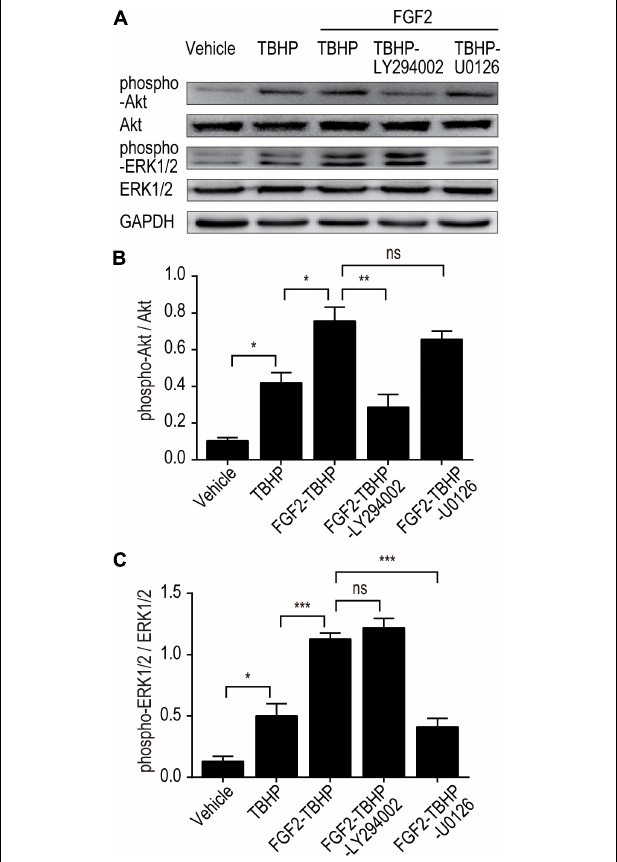
FIGURE 7 | LY294002 and U0126 abolish the effect of FGF2 on the phosphorylation of Akt and ERK1/2 in vitro . (A) The phosphorylation of Akt and ERK1/2 was determined by Western blotting analysis. GAPDH was used as a loading control. Images are representative of five animals in each group. (B,C) The histograms show the normalized optical density analysis. LY294002 inhibited the effect of FGF2 treatment on the phosphorylation of Akt, whereas U0126 strikingly blocked the effect of FGF2 on the phosphorylation of ERK1/2. Representative data of five individual samples in each group. * P < 0.05, ** P < 0.01, *** P < 0.001; ns indicates not statistically